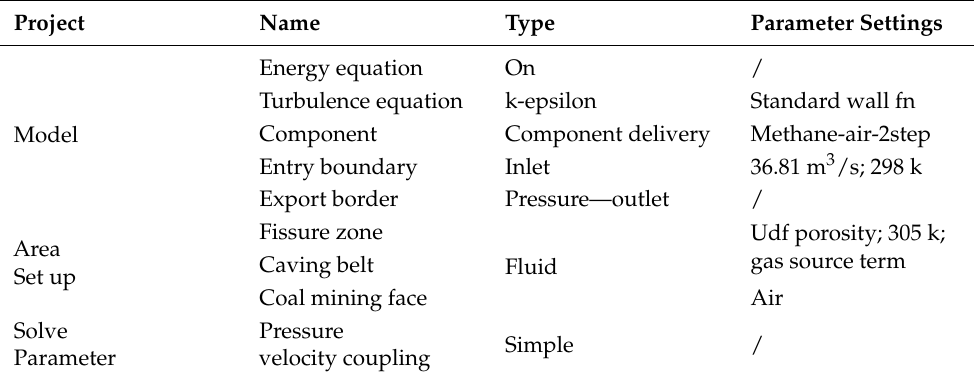
Table 1. Boundary condition parameter